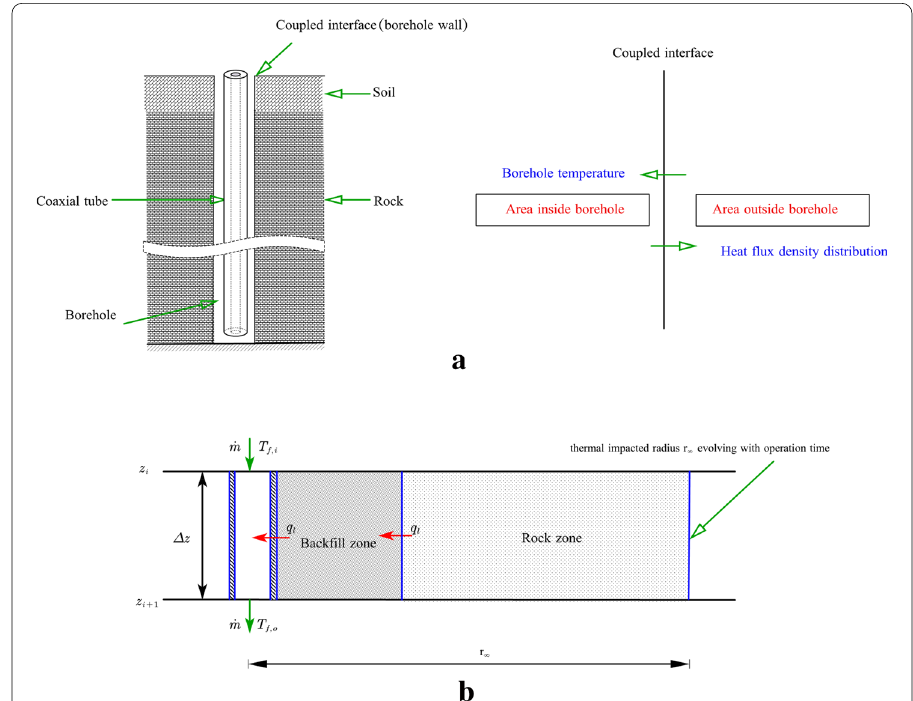
Fig. 3 Calculation approach for DBHE: a Coupling of the two areas in simulation for coaxial DBHE. b Dynamic evolution of thermal impacted radius (heat propagation front) outside